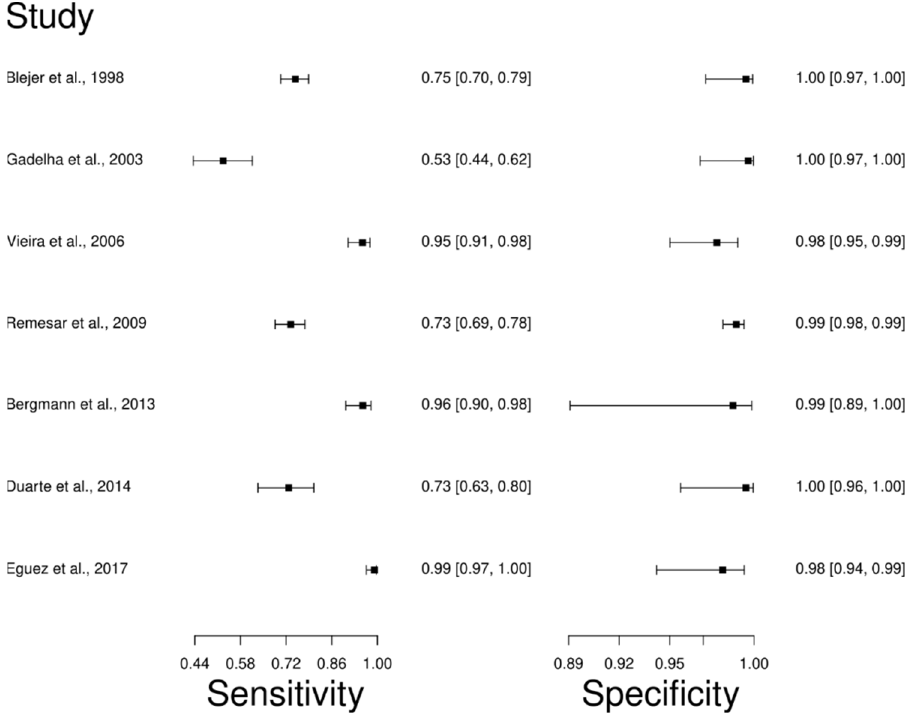
Figure 6. Study data and paired forest plot of the sensitivity and specificity Hemagglutination test (HmT) in Chagas’s disease diagnosis. Data from each study are summarized. Sensitivity and specificity are reported with a mean (95% confidence limits). The Forest plot depicts the estimated sensitivity and specificity (black squares) and its 95% confidence limits (horizontal black line)